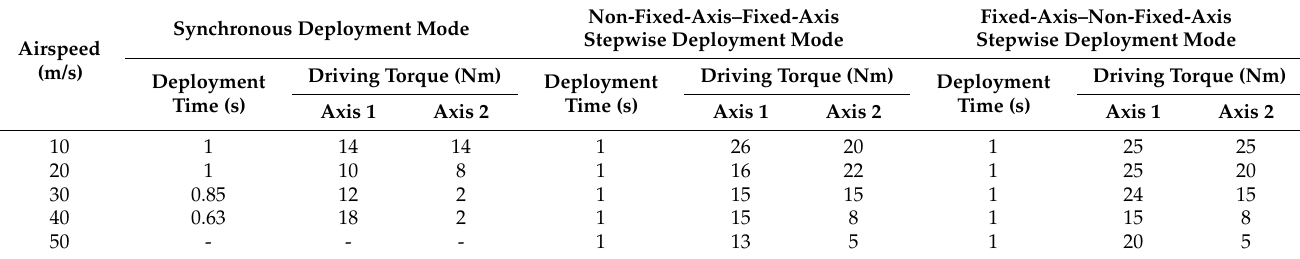
Table 3. Minimum driving torque required for folding wing deployment at different airspeed and deployment modes.